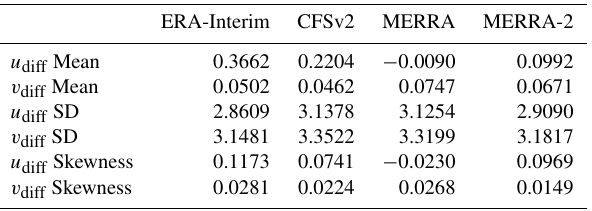
Table 2. Statistics of the wind differences between the reanalyses and the Loon balloons. Corresponding histograms are plotted in Fig. 3. Units are ms − 1 . ERA-Interim CFSv2 MERRA MERRA-2